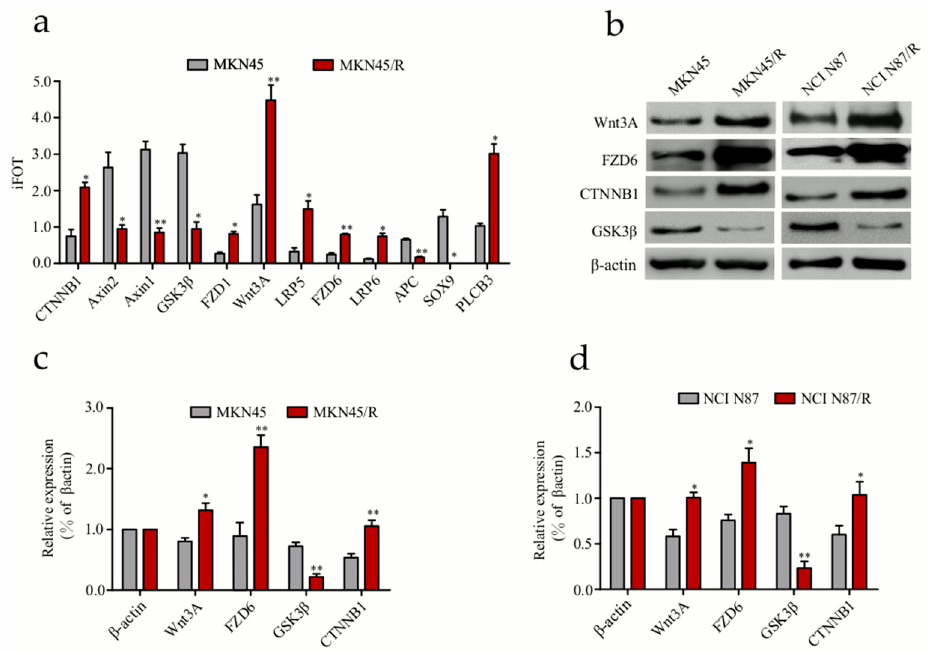
Figure 4. Validation of differentially expressed proteins in Wnt/ β -catenin signaling pathway. ( a ) Twelve Wnt/ β -catenin pathway components differentially expressed in MKN45/R and MKN45 cells were measured by mass spectrometry; ( b ) Expression of some Wnt/ β -catenin pathway proteins detected by western blot. β -actin was used as a loading control; ( c , d ) Quantification of Western blot signals in two groups of cell lines. Three independent biological replicates were shown as mean ± SEM. * p < 0.05, ** p < 0.01 vs. control.